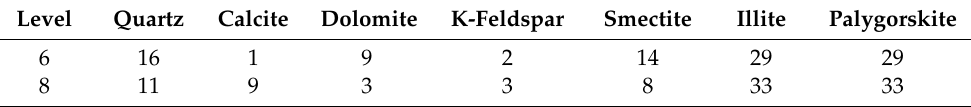
Table 1. Mineralogy of the clay levels identified within the DC Formation. The mineralogical semi- quantification was also performed using the oriented aggregates (OA) and after applying the method of reflective powers.